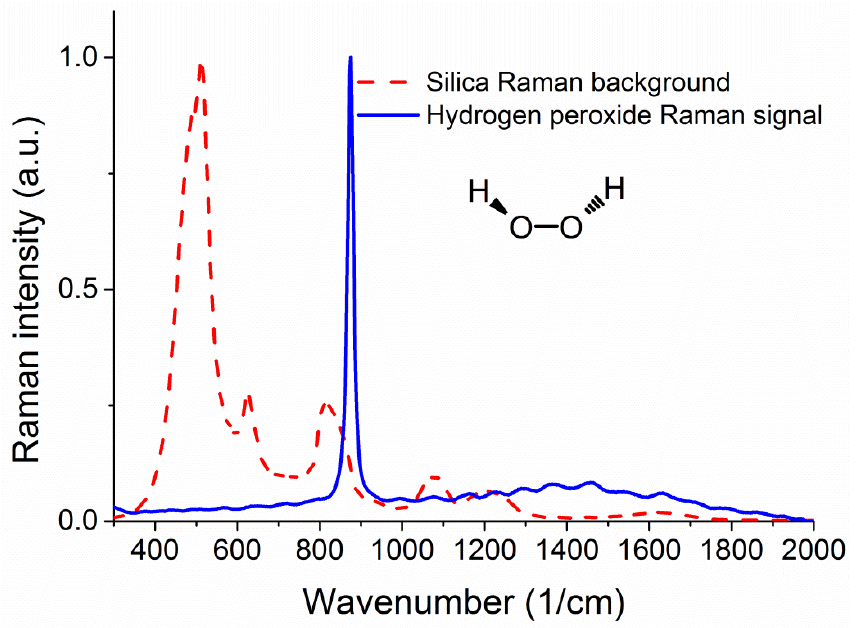
Figure 2. Raman spectra of silica glass (red dashed line) and hydrogen peroxide (blue solid line). The spectra have been normalized to their maximum value for